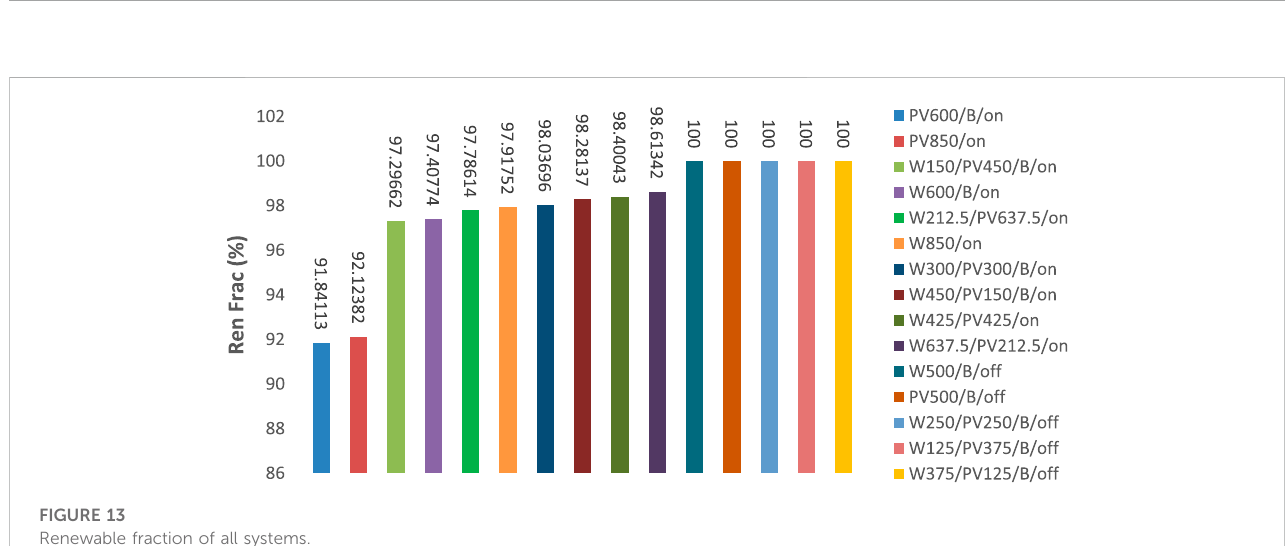
FIGURE 12 Operation and maintenance of all systems.